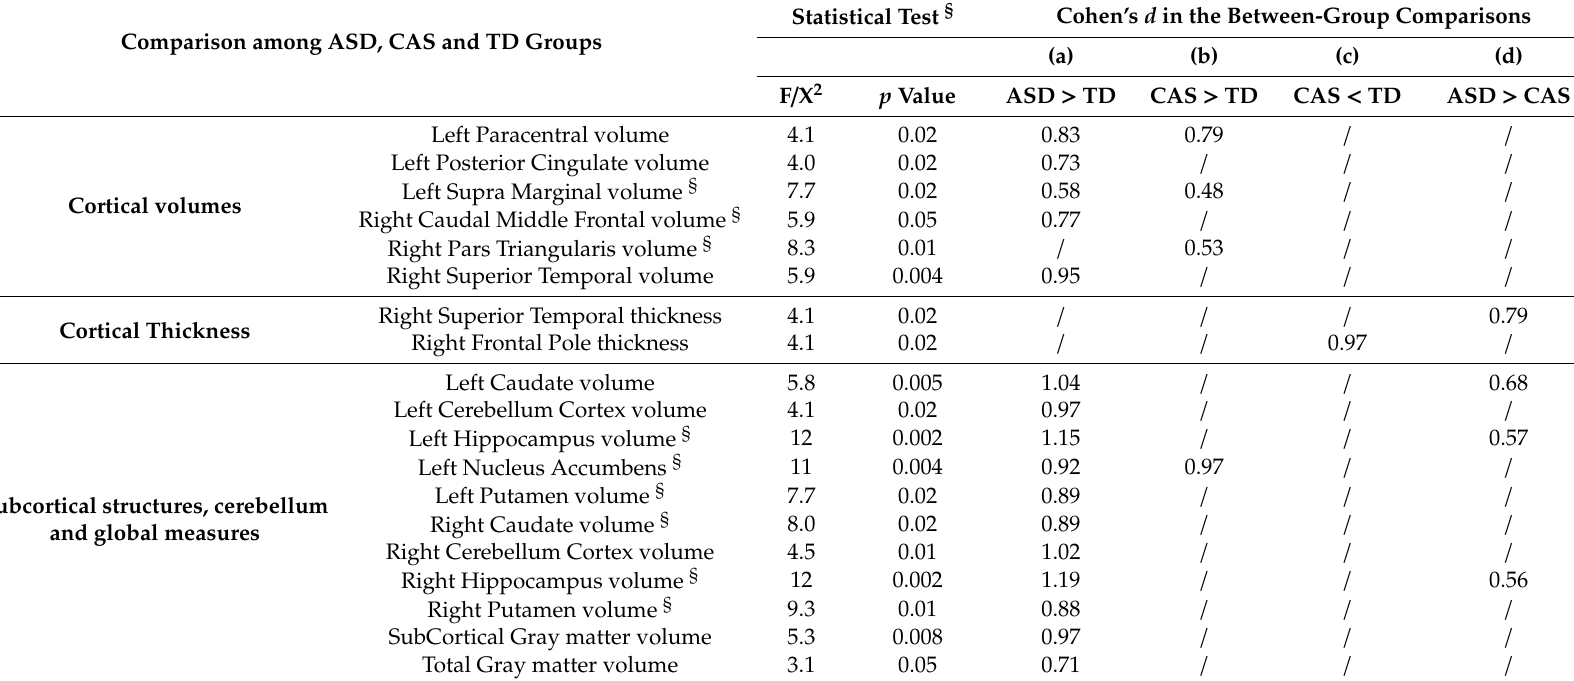
Table 2. Cortical volumes showing a statistically significant di ff erence in the comparison among children with ASD, children with CAS and TD children. The test statistics (either ANOVA or Kruskal-Wallis), the p-values, the specification of which group comparisons showed statistically significant di ff erences and the related e ff ect size in terms of Cohen’s d are